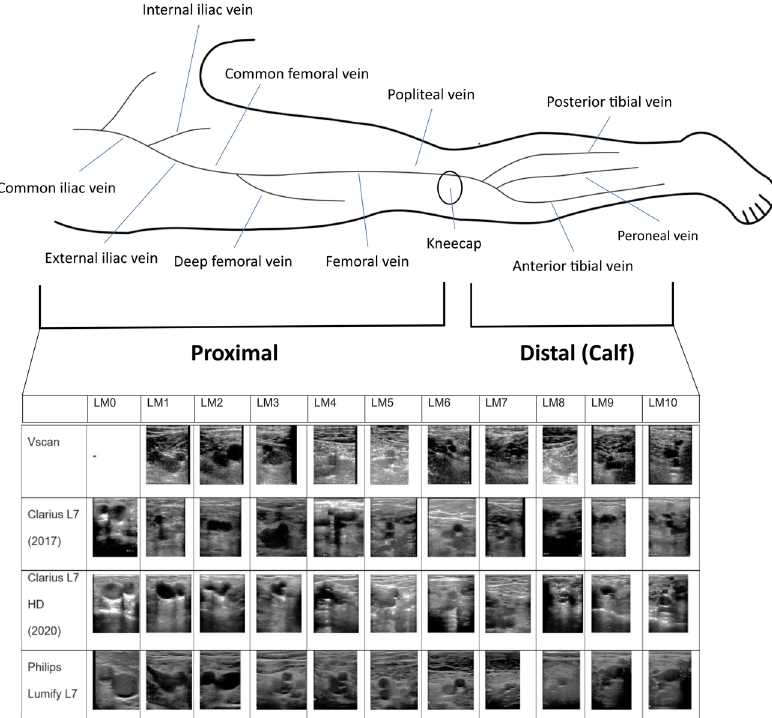
Fig. 8 Examples of the chosen anatomically salient landmarks and overview over the investigated anatomy. Images have been acquired by different acquisition devices and from different subjects. This fi gure illustrates the diversity in our dataset. See the overview above the table and Tables 7 and 8 for a description for the location of these landmarks. These example images have been manually cropped and contrast normalised for better